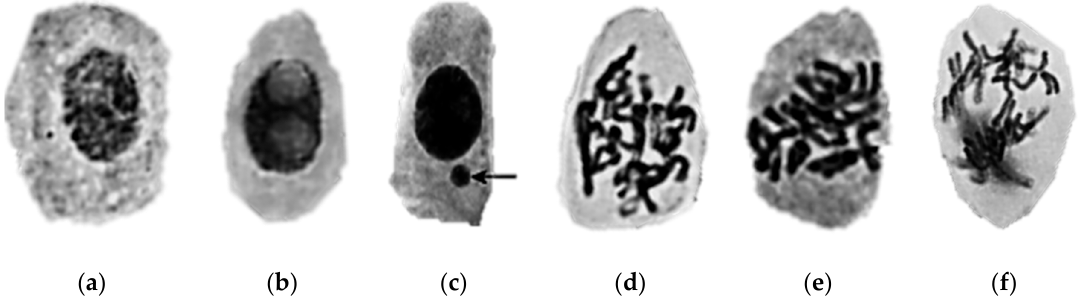
Figure 35. Chromosomal aberrations observed in Allium cepa meristematic cells exposed to ZnO NPs. ( a ) Normal cell in prophase; ( b ) binucleated cells at early telophase; ( c ) prophase nucleus with micronucleus; ( d ) disturbed metaphase; ( e ) disturbed anaphase and ( f ) multipolar anaphase. (Modified after [143] ).